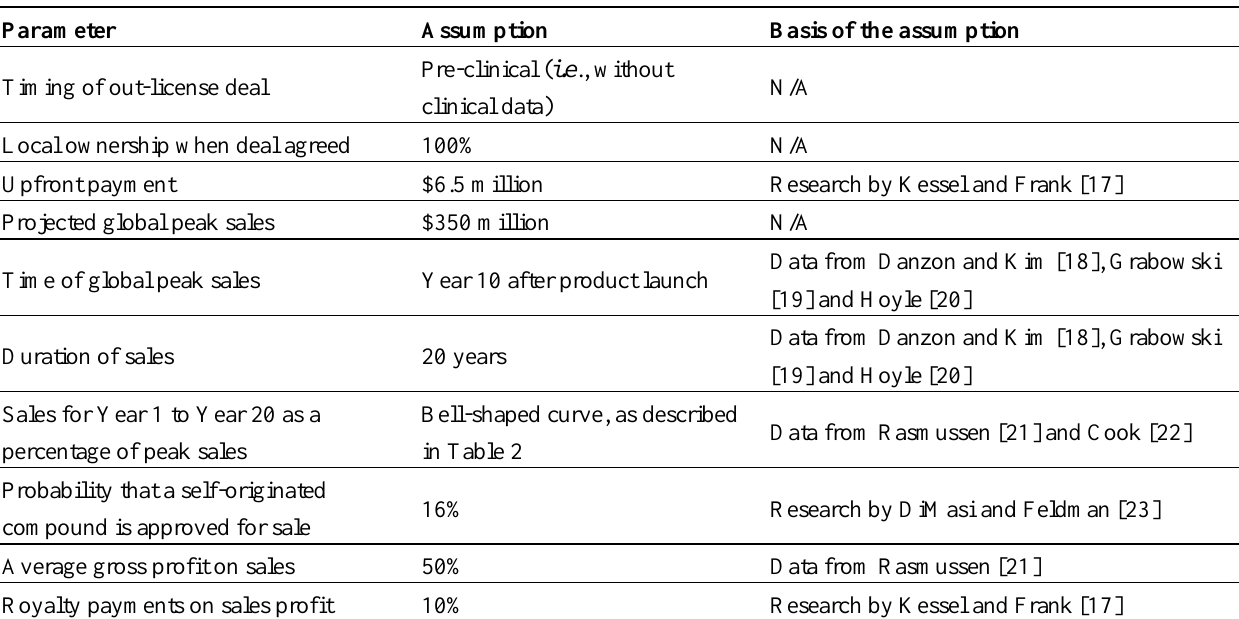
Table 1. Assumptions for the calculation of potential revenue from drug